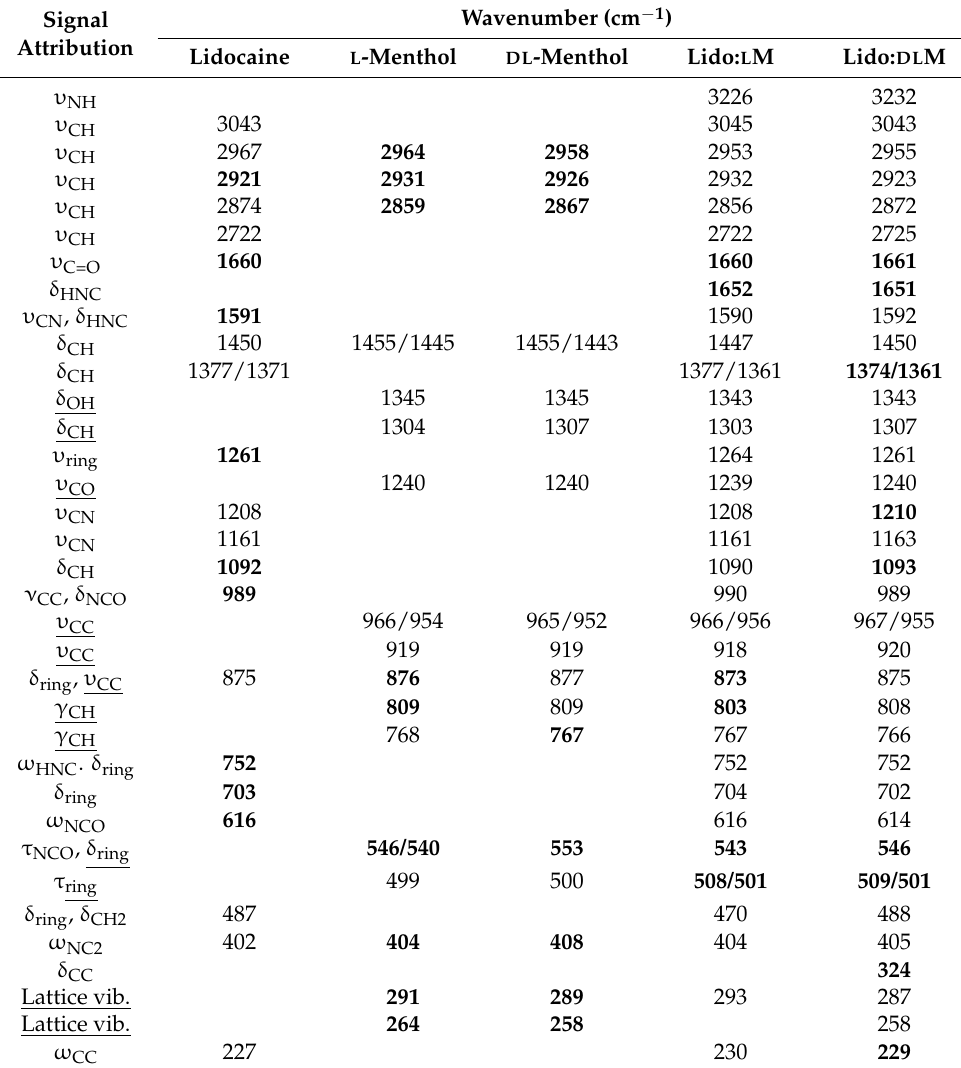
Table 3. Raman spectroscopic results obtained for solid enantiopure and the menthol racemate-based cocrystals, and the components taken separately. υ : stretching, δ : in-plane bending, γ : out-of-plane bending, τ -torsion, and ω - wag vibrations. Data in bold indicate main signals. Menthol-exclusive bands are